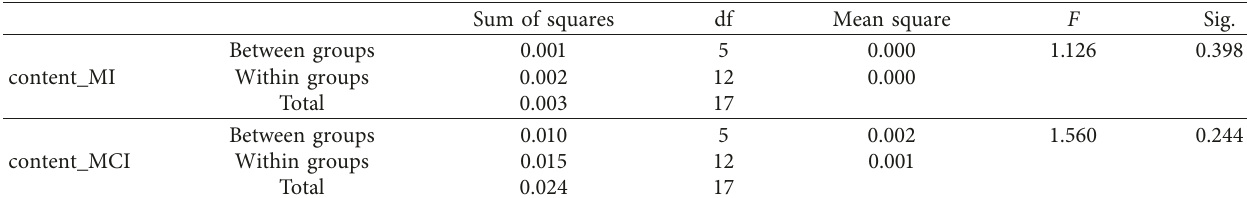
Table 7: Results of ANOVA analysis for content of MI and